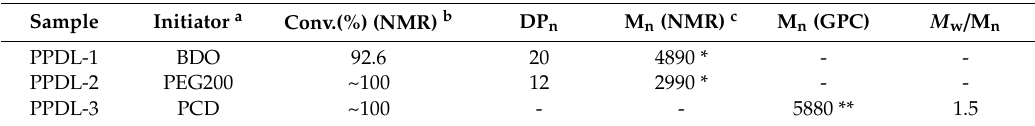
Table 3. The conversion, DP n and M n values for the samples PPDL-1, PPDL-2, and PPDL-3 determined by 1 H-NMR and